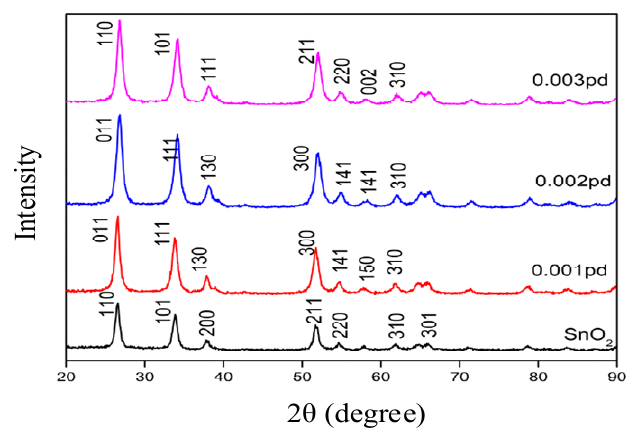
Figure 5. X-ray di ff raction intensity of pure SnO 2 , SnO 2 with 0.1% Pd (labeled as 0.001 pd), SnO 2 with 0.2% Pd (labeled as 0.002 pd) and SnO 2 with 0.3% Pd (labeled as 0.003 pd), given in count values at an angle 2 θ